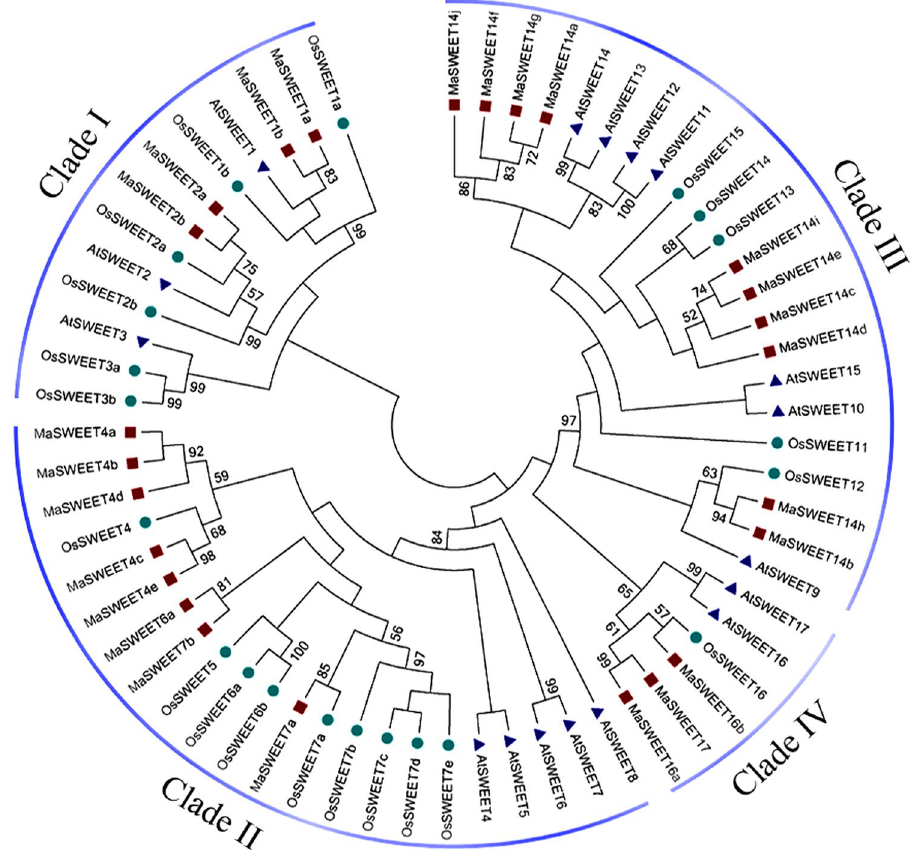
Figure 1. Phylogenetic analysis of the SWEETs from Arabidopsis , rice and banana. The Neighbor-joining tree was drawn using MEGA5.0 with 1000 bootstraps. Four subgroups were identified and classified as Clades I-IV.